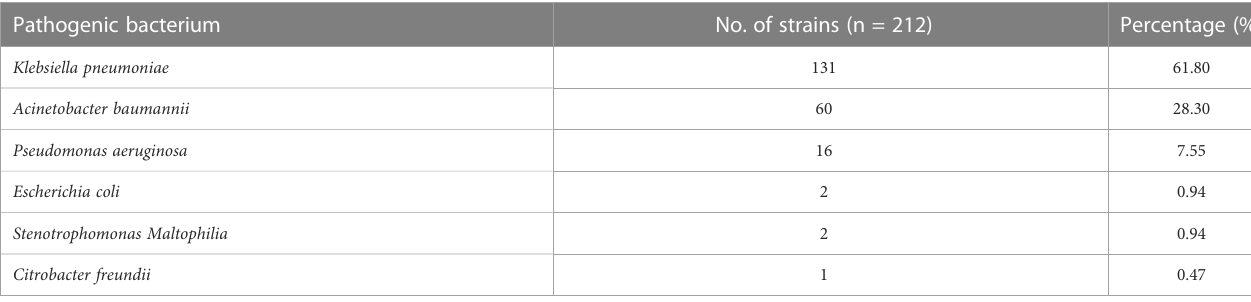
TABLE 1 Distribution of pathogenic bacteria associated with CR-GNB